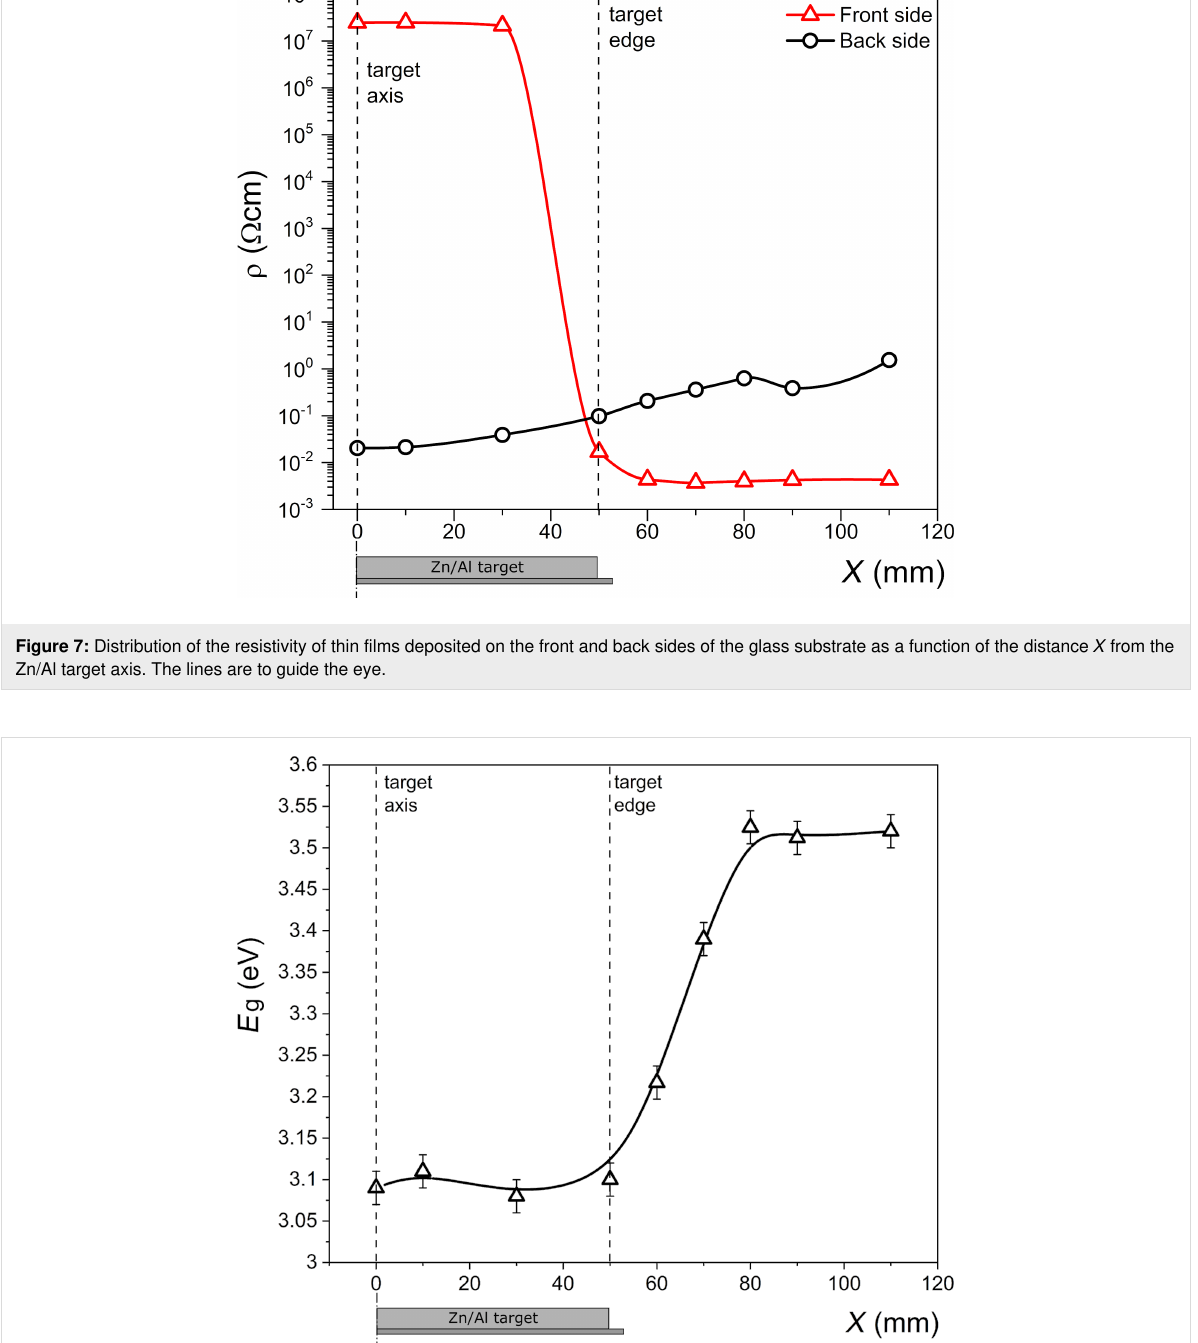
nal ZnO phase. The crystallite size was calculated using the Scherrer formula [23]. The results of GIXRD measurements showed that all films were nanocrystalline. Thin films deposited directly above the Zn/Al target, that is, on the target axis and